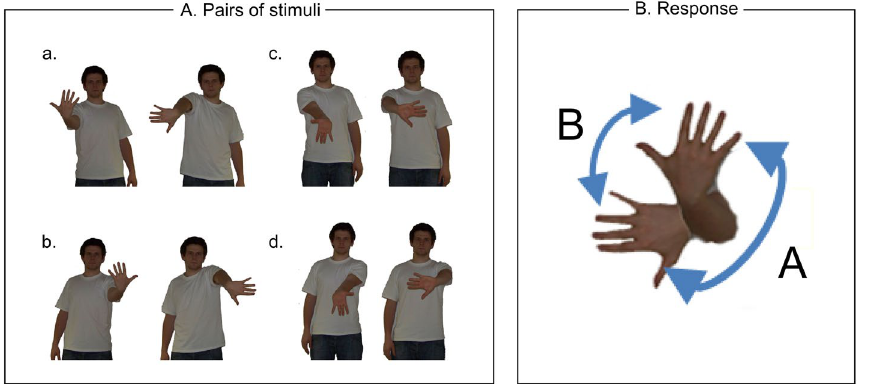
Figure 2. Stimuli and procedure of the apparent body movement perception task. ( A ) Illustration of the different pairs of pictures, whose respective sequential presentation induces the illusion of movement of the upper limb of the actor. The actor either raises his right (a and c) or left limb (b and d) with the forearm in supine position and the wrist either in flexion (a and b) or in extension (c and d). The second picture of the pair depicts the position of the forearm and the hand resulting from a pronation of the forearm by a medial rotation movement. ( B ) Example of the figure prompting the participants to respond by choosing between the two possible paths (labelled A and B) of apparent movement between the two hand positions shown in the pair of pictures presented in the trial. In this specific example, participants choose the perceived path of movement between the two hand positions presented in pair